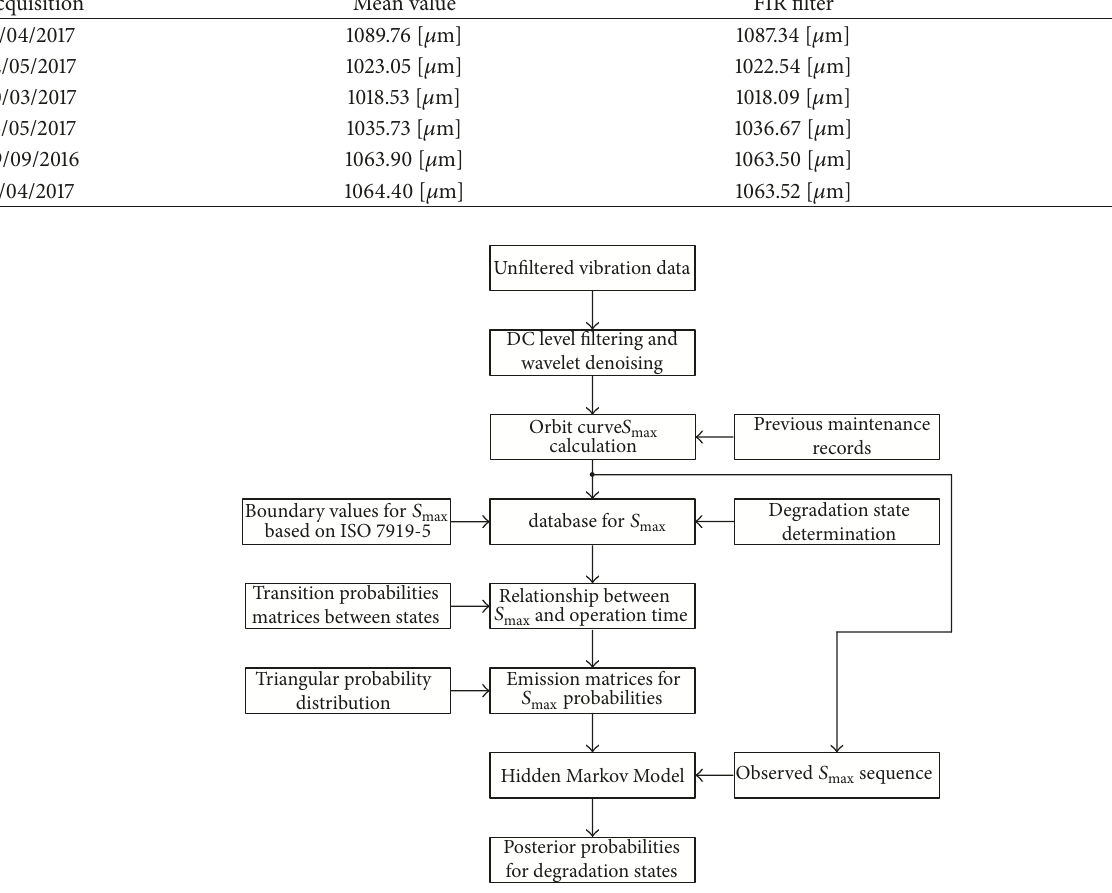
Figure 4: Methodology flowchart.